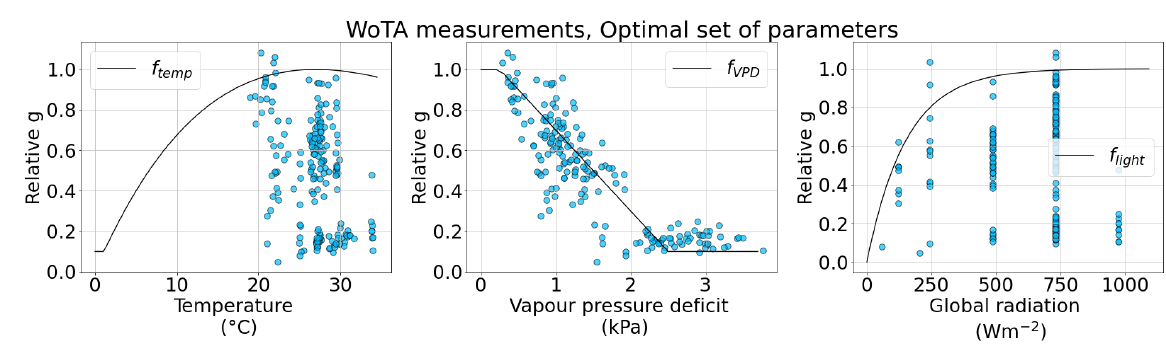
Figure 4. Relative stomatal conductances for the WoTA dataset represents the ratio between the stomatal conductance and maximal stomatal conductance g max . In the upper plots g max = 125 µ mol O 3 m − 2 PLA s − 1 and in the lower plots g max = 113 µ mol O 3 m − 2 PLA s − 1 . Blue dots represent the actual measurements and the black lines represent the modeled values of reduction factors f temp , f VPD , and f light